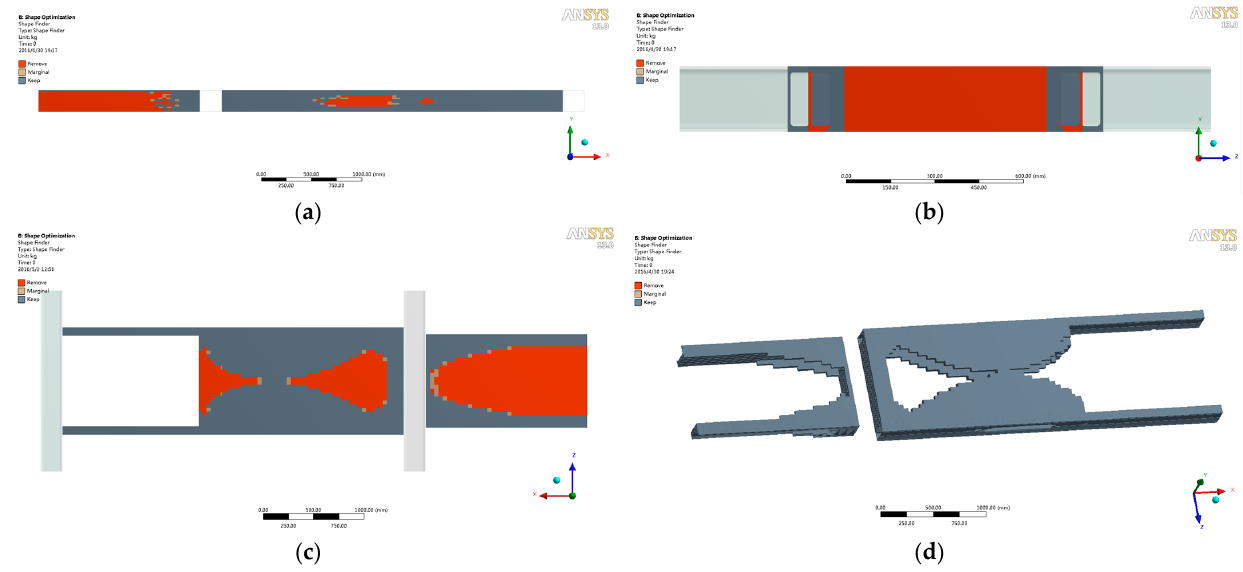
Figure 11. Topology optimization results for static bending conditions. ( a ) Front face; ( b ) Left face; ( c ) Top face; ( d ) Retained fraction with density of 1.